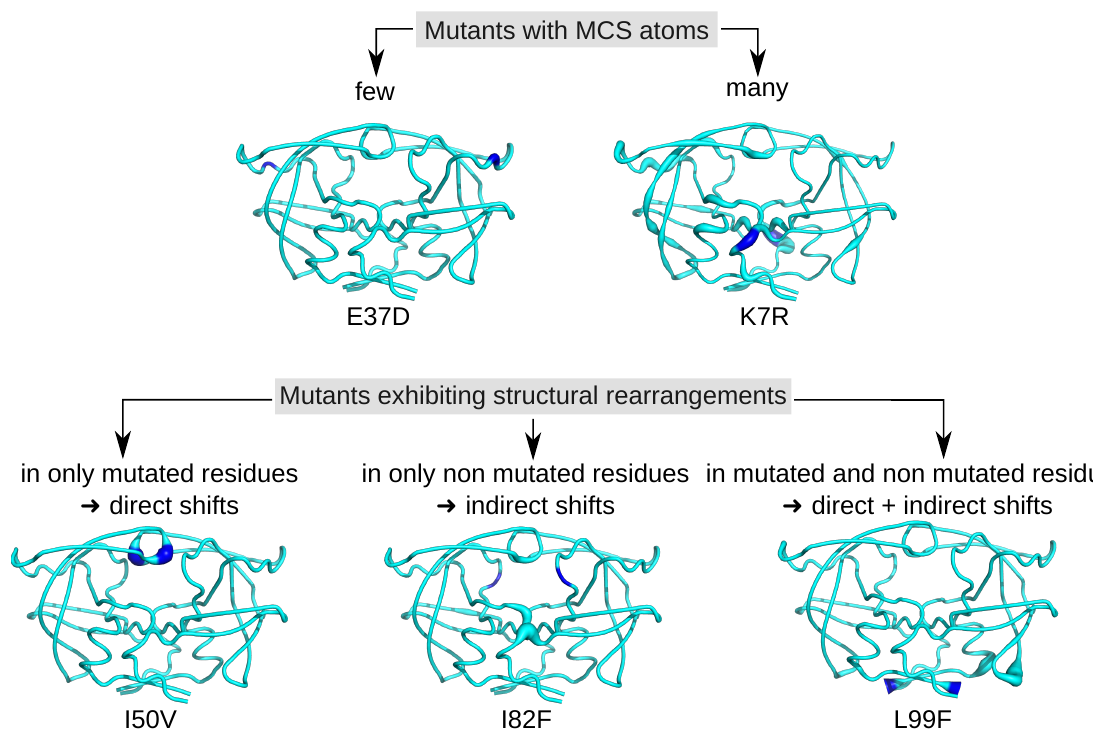
Figure 4. Location of the MCS atoms found in some mutants. PR2 is colored in cyan and represented in putty mode. The putty radius is relative to deformations induced by mutations: the higher the radius, the stronger the mutation-induced rearrangement. Mutated residues are colored in